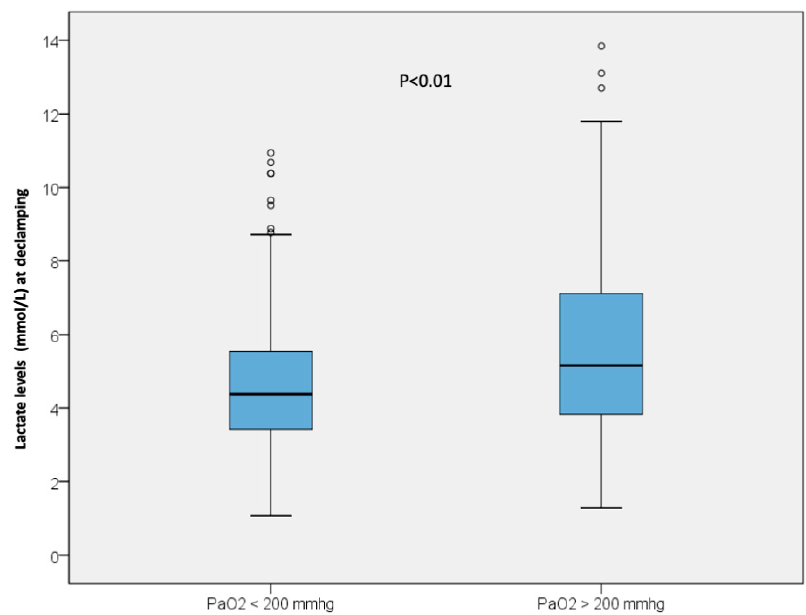
Figure 2. Lactate level at 15 min after graft reperfusion in the non-hyperoxic group and in the hyperoxic group.